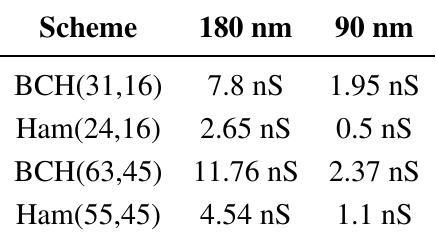
Table 3. Delay Comparison of ECC Blocks BCH vs .